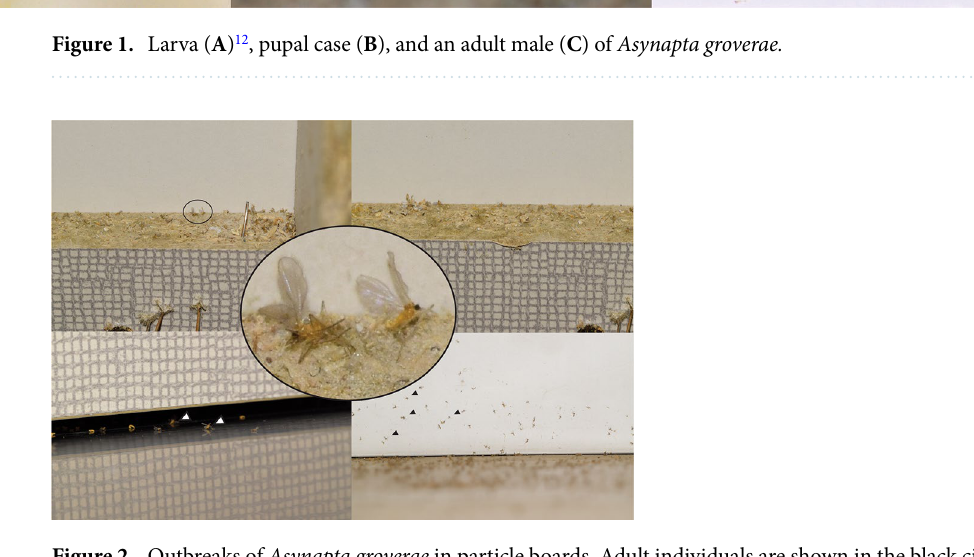
Figure 2. Outbreaks of Asynapta groverae in particle boards. Adult individuals are shown in the black circle and black and white. Not all individuals are